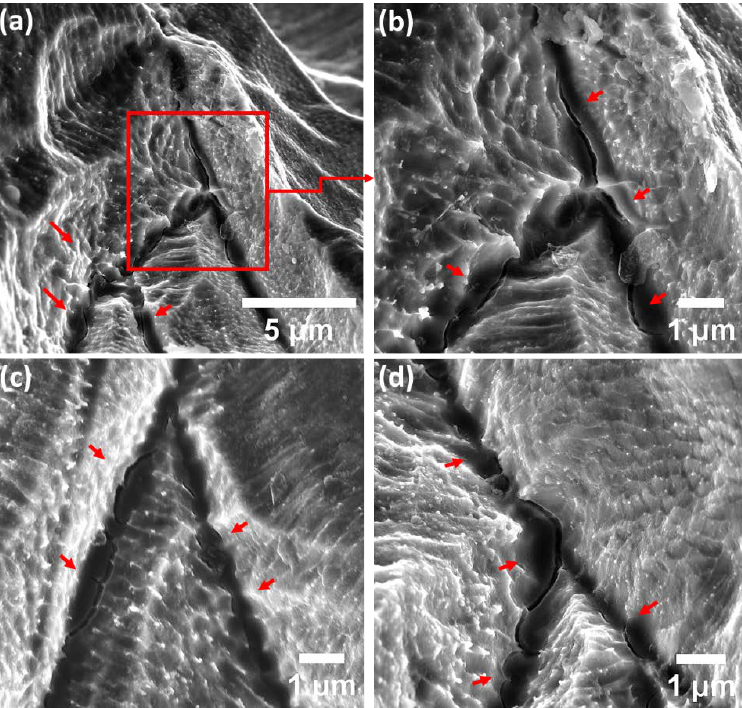
Figure 9. ( a – d ) High magnification of the SCC morphology (shown by red arrows) for the specimens in group three with the presence of LOF pores.